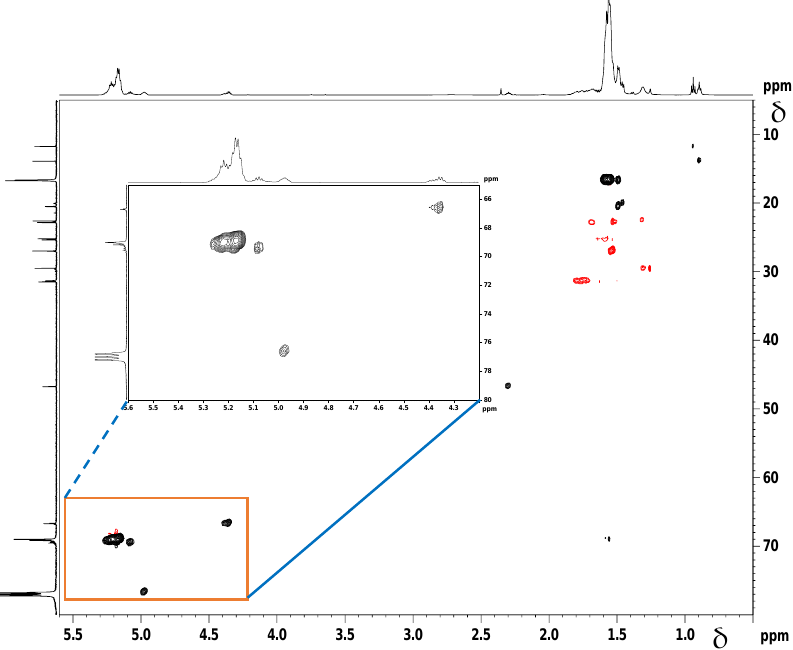
(CH 2 ) 2 - CH -O-C(O)- group in the initiator cyclooctanol (group b in the structure in Figure 6A).